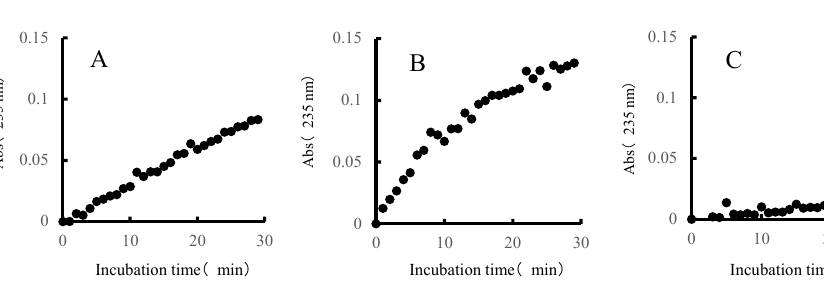
Figure 3. Determination of ulvan-degrading ability in bacteria. The 13 isolates of ulvan-degrading bacteria were cultured in medium containing ulvan for five days, and then immersed in CPC solution. 1a , Alteromonas sp. ul20-2; 1b , Pseudoalteromonas sp. AR06; 2a , Echinicola sp. 20G; 2b , Vibrio sp. 10N; 3a , Alteromonas sp. N2; 3b , Alteromonas sp. N3; 4a , Algibacter sp. 1G-1; 4b , Pseudoalteromonas sp. DN-1; 5a , Pseudoalteromonas sp. DN-3; 5b , Nonlabens sp. DG-3; 6a , Pseudoalteromonas sp. 6G-1; 6b , Paraglaciecola sp. MN-1; 7a , Paraglaciecola sp. MN-2; 7b , Algibacter sp. 1G-1-2.